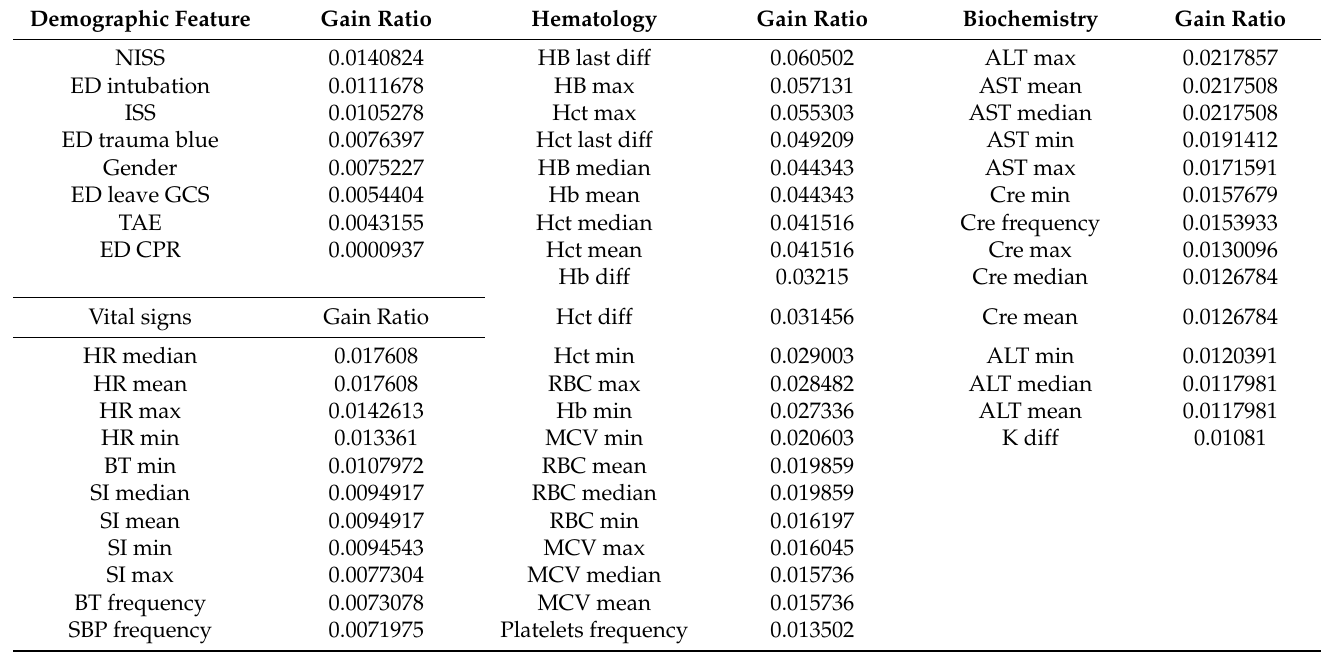
Table 2. The Gain Ratio attribute.